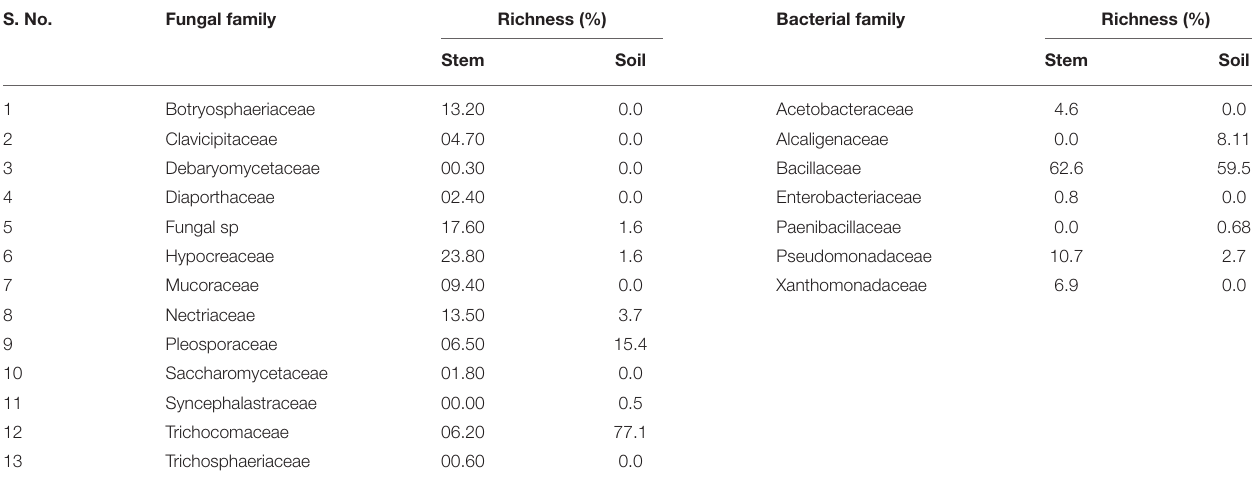
TABLE 1 | Family dominance of fungus and bacteria isolated from stems and soil samples of A. malaccensis . S.